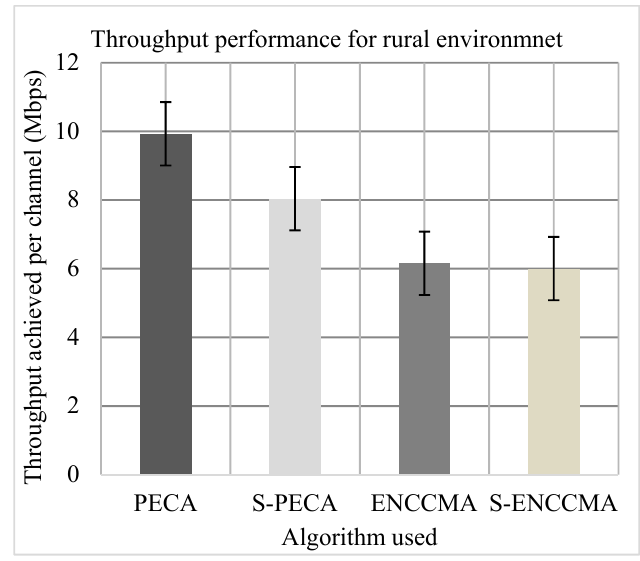
Figure 9. Throughput performance for the rural environment.